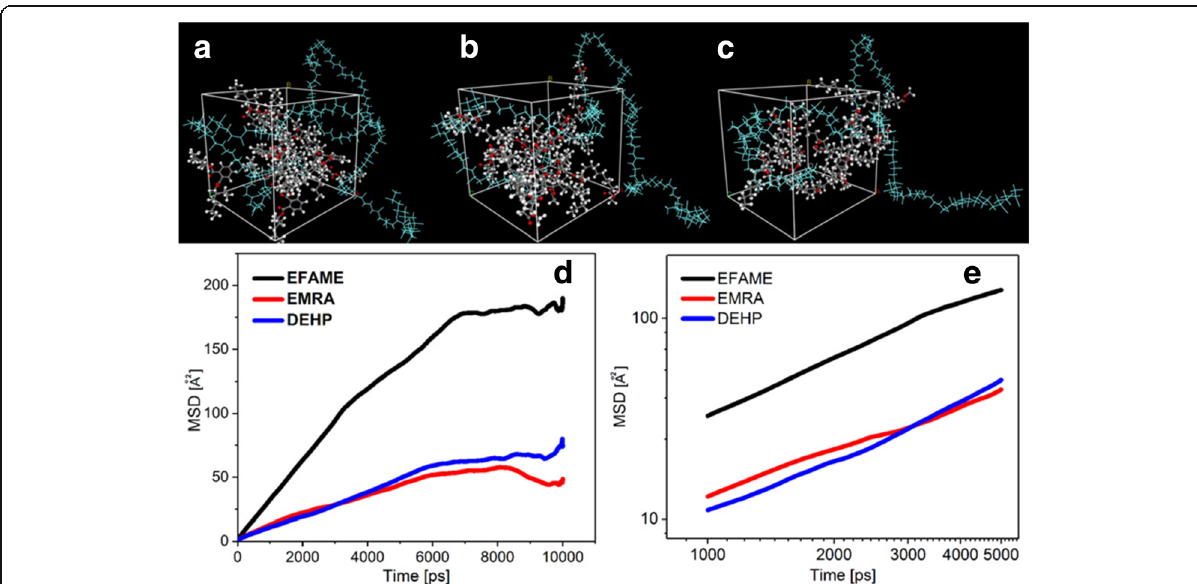
Fig. 5 Three-dimensional amorphous cell of PVC matrix containing ten a DEHP; b EMRA; c EFAME, well-equilibrated at 450K by using NPT assemble ( P =1 bar) after an annealing procedure. d MSD vs. time plots of the plasticizer molecules over the NPT dynamics run. To illustrate that a normal diffusion regime was reached where the Einstein relation was valid for self-diffusion coefficients calculation, the log (MSD) vs. log (t) plots of the plasticizer molecules in the range of 1000 – 5000ps were shown in e . Note that the slope of the log (MSD) vs. log (t) plots in e approached